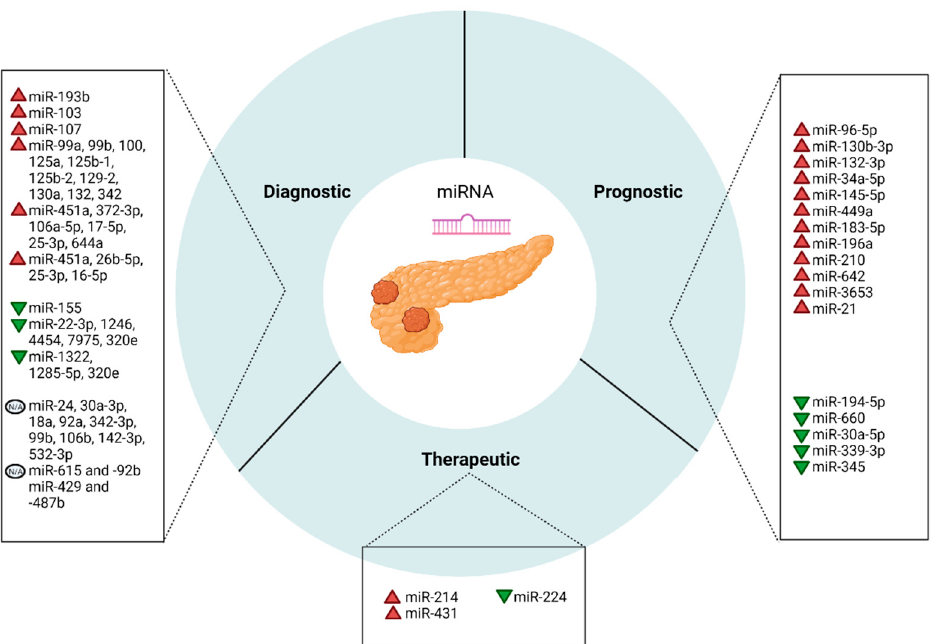
Figure 2. Schematic illustration of the effect of miRNAs as diagnostic, prognostic, and therapeutic biomarkers in PanNETs.